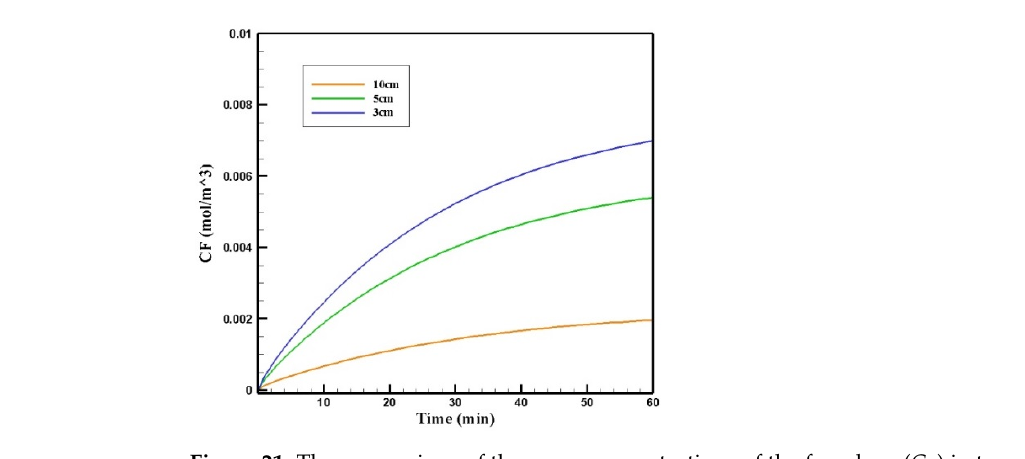
at different distances between the magnetic source and the tumor center.